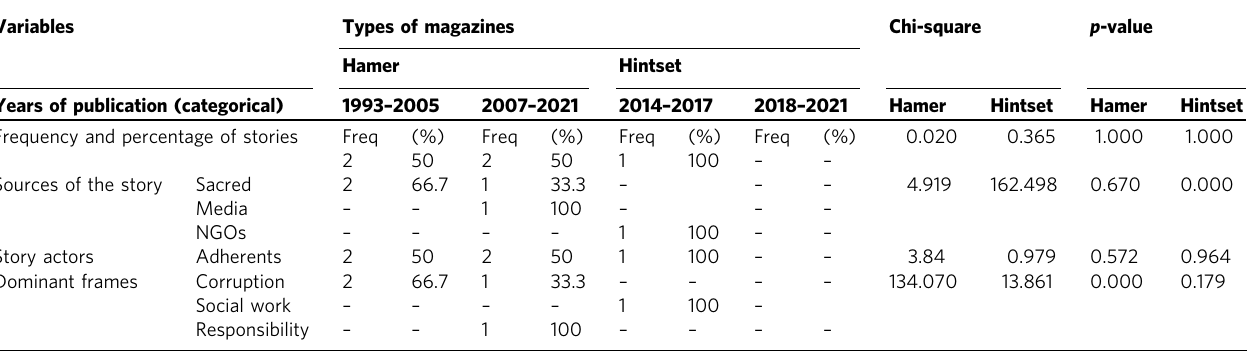
Table 8 Cross-Tabulation: Natural resource development * Types of publication * Years of publication * Sources * Story actors * Dominant